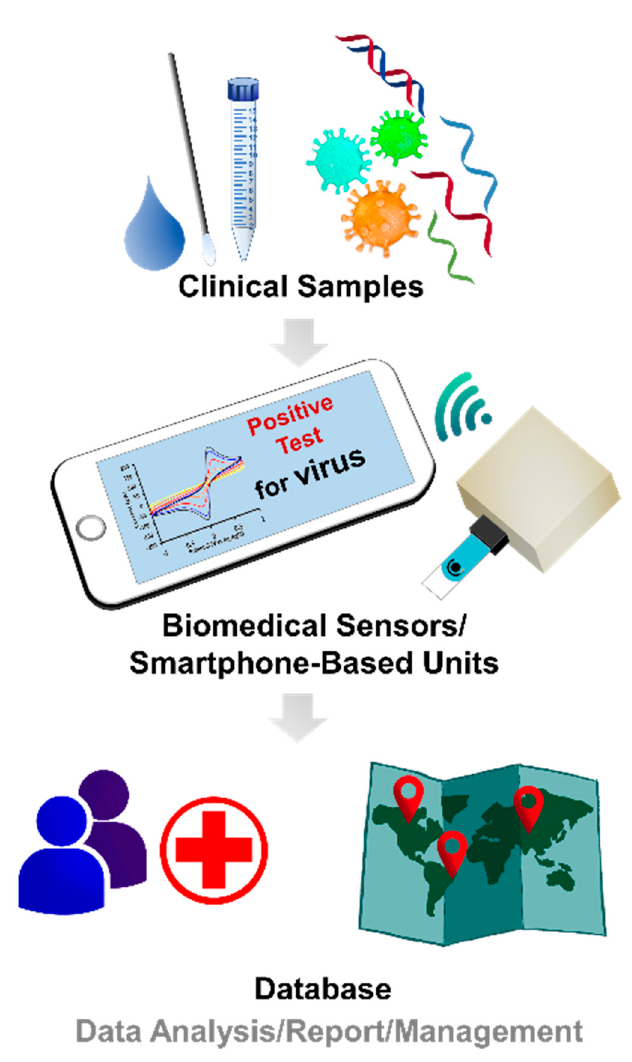
Figure 8. Schematic illustration showing that the out-of-clinic electrochemical sensor can allow convenient biomedical diagnosis. The data can be sent out to the integrated network, connecting the individual, the local healthcare unit, and the national or international public health organization.